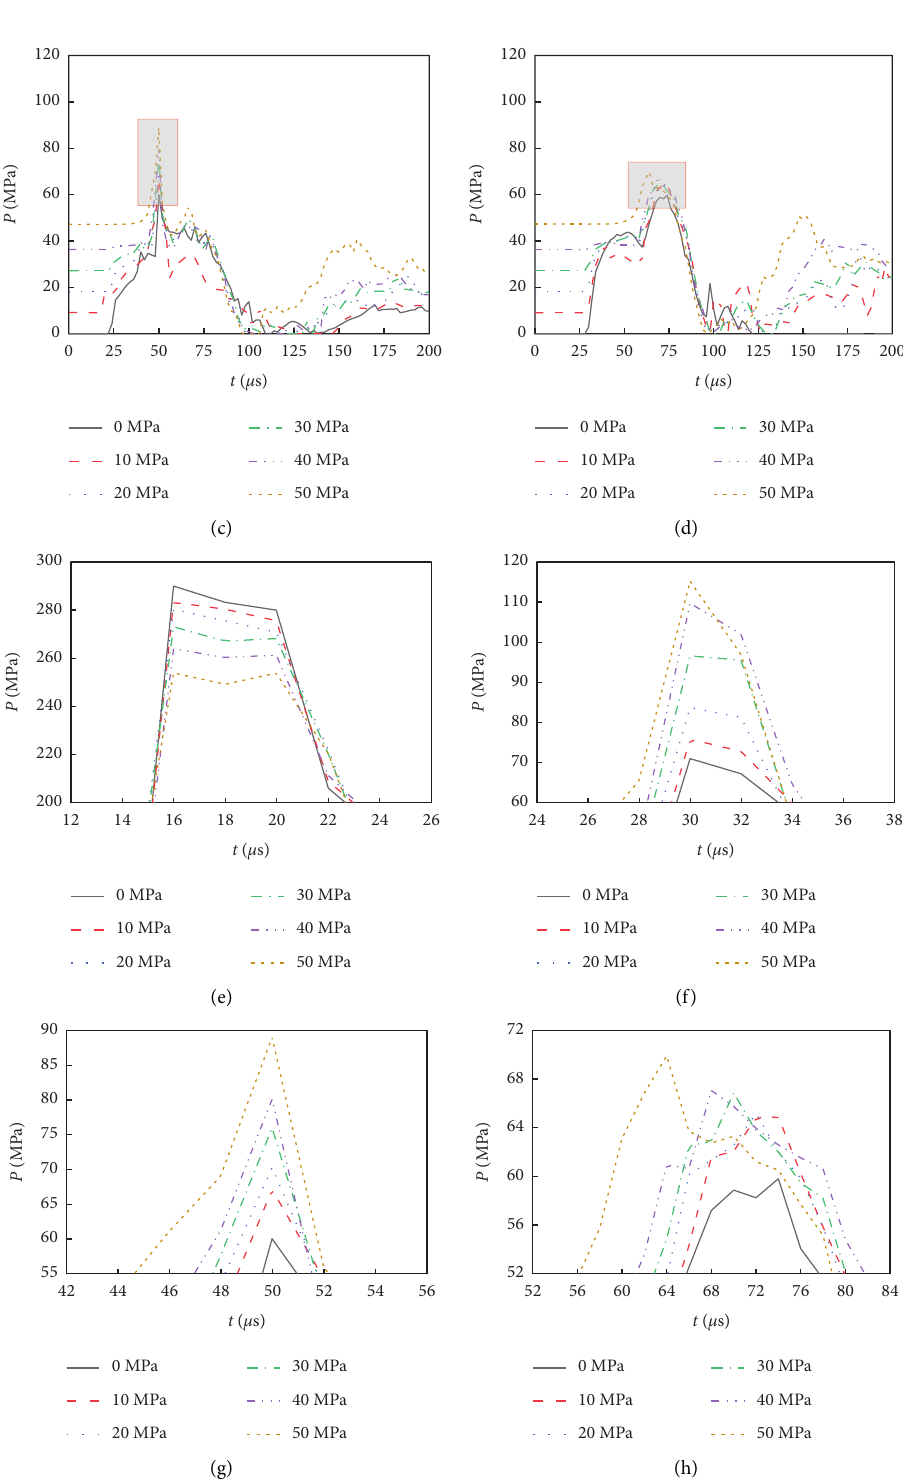
Figure 5: Stress-time curves of measuring points at different distances under two-way equal pressure. (a) d � 5 cm. (b) d � 10 cm. (c) d � 15 cm. (d) d � 20 cm. (e) d � 5 cm. (f) d � 10 cm. (g) d � 5 cm. (h) d � 10